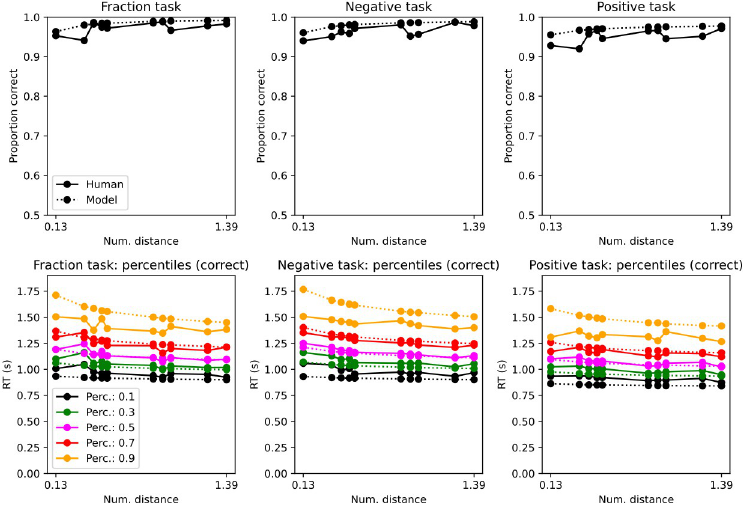
Fig 6. Accuracy (top) and response time distributions by percentiles (bottom) by trial type (Exp 2.). Numerical distance in log. scale. Response times are for correct trials; see Supplemental Information for incorrect